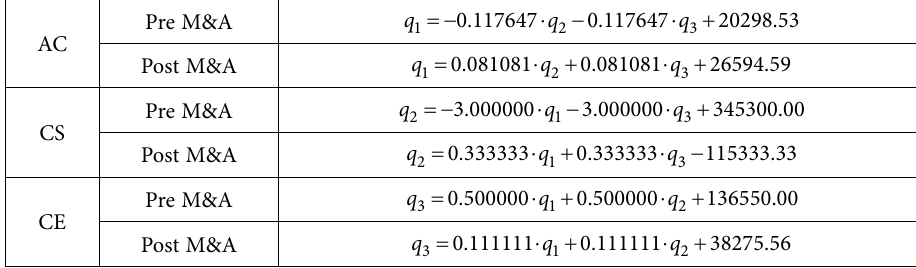
Table 5. Pre and Post M&As best response functions for the Big